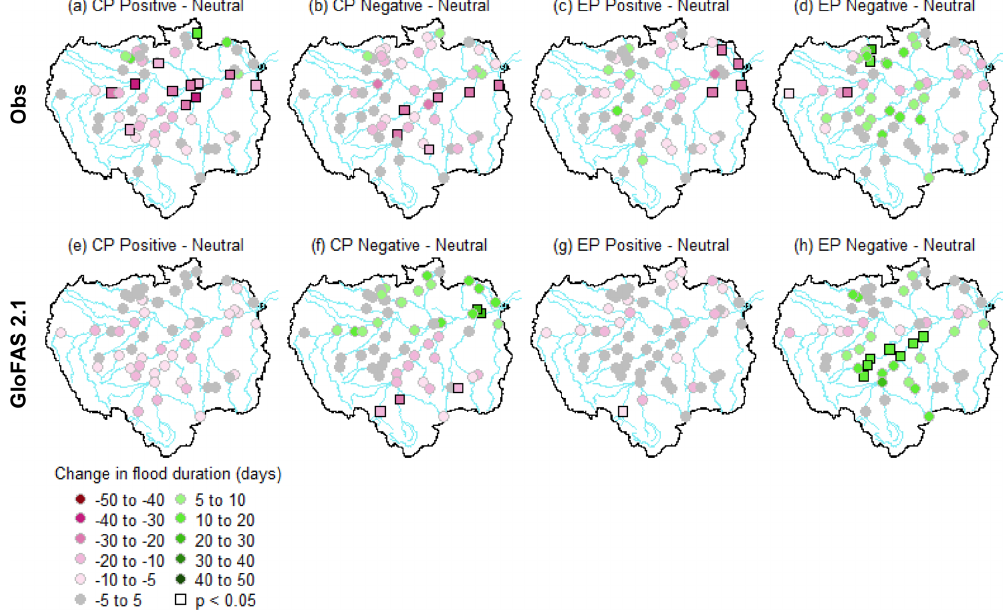
Figure 9. Changes in flood duration (i.e. mean number of days river flows exceed the 95th percentile of each station or grid point climatology) for different phases of the CP and EP indices. (a, c, e, g) Positive with respect to neutral years. (b, d, f, h) Negative with respect to neutral years. Panels (a–d) represent changes for observations and panels (e–h) show changes for GloFAS 2.1 streamflow reanalysis data. Pink (green) points represent decreases (increases) in the number of days spent above the 95th percentile compared to neutral conditions. Significant results at the 95% confidence level are denoted using a square (i.e. p < 0 . 05).